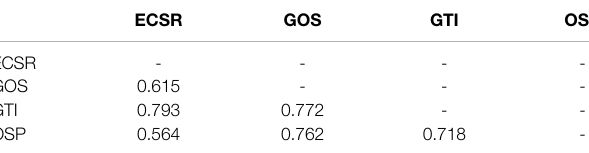
TABLE 2 | Fornell-Larcker criterion. TABLE 3 | HTMT